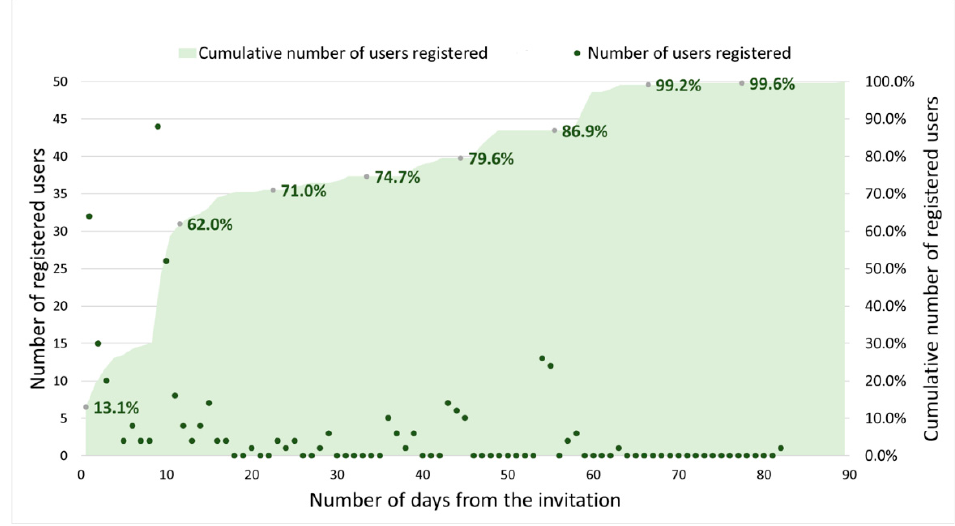
Figure 8. Consumer registration after invitation in days.